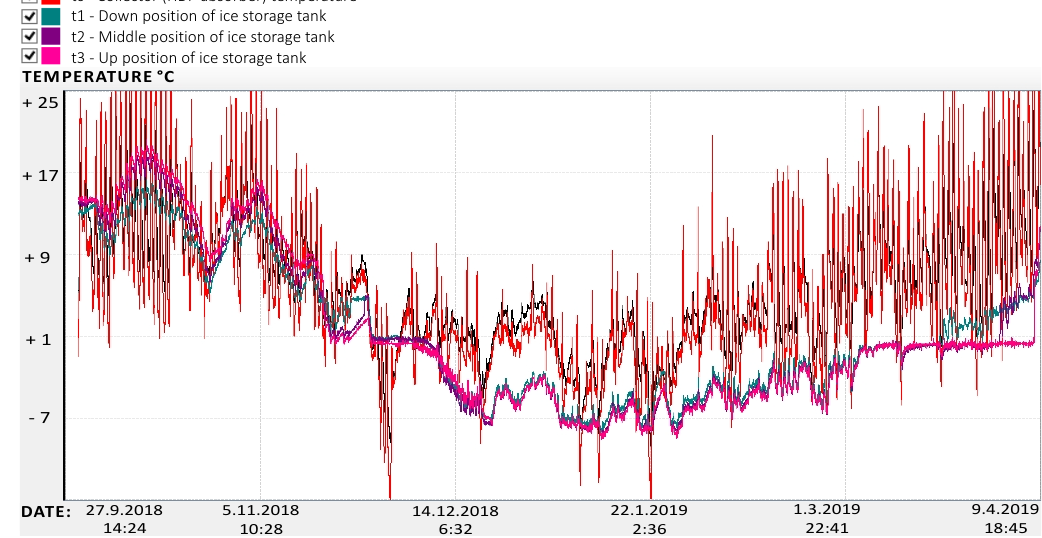
Figure 15. Overall view of temperatures.